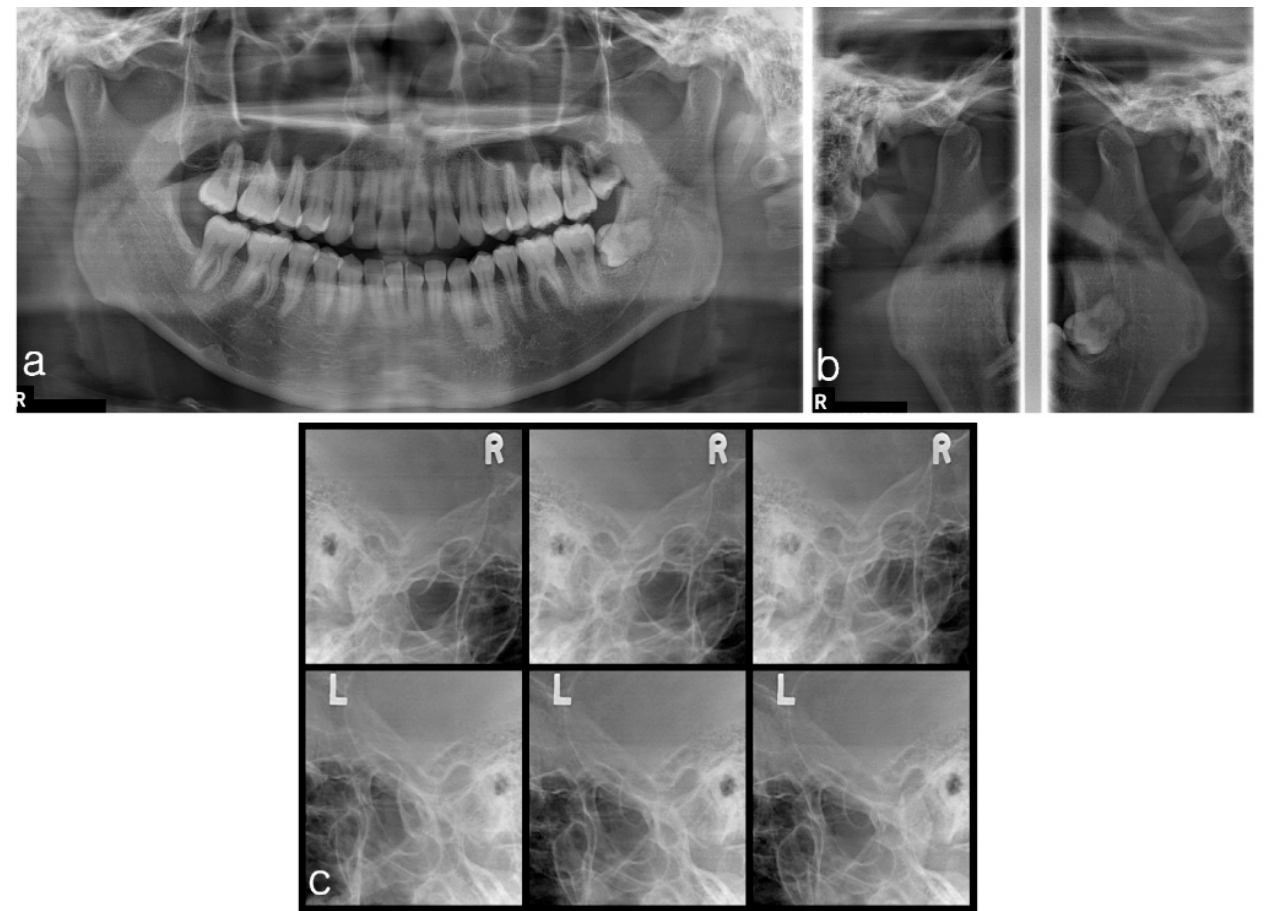
Figure 5. Plain radiographs taken at first visit. Incipient degenerative change on the left condyle. ( a ): panoramic view; ( b ): TMJ panoramic view; and ( c ): transcranial view.